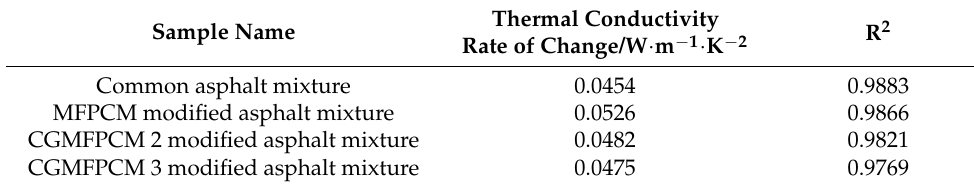
Figure 9. Measured volume-specific heat capacities of common and modified asphalt mixtures. Table 16. Thermal Conductivity Rate of change of common and modified asphalt